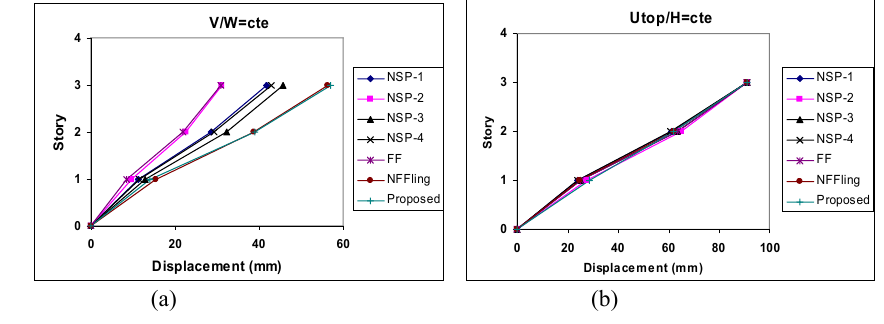
Figure 8. Peak displacement profiles for the 3-storey building with (a) V/W=cte, (b) U Fig. 8. Peak displacement profiles for the 3-storey building with (a) V/W = cte, (b) U top /H = cte.